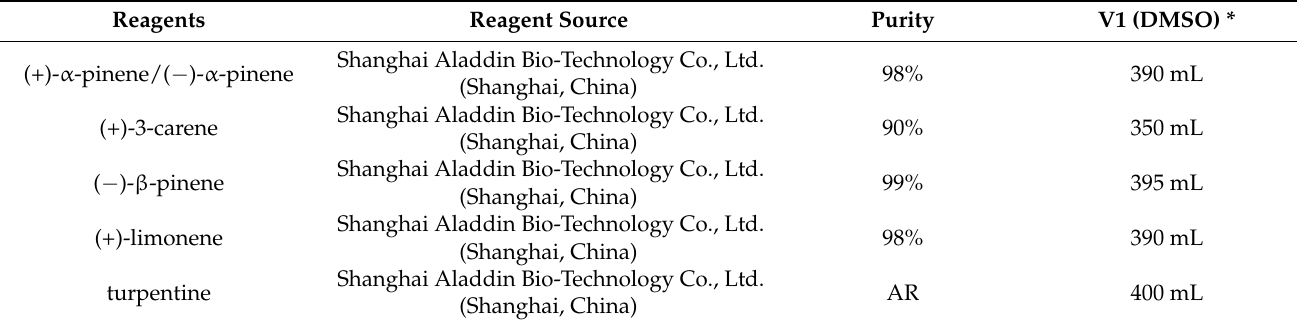
Table 1. Description of the main reagents used in terpenoid